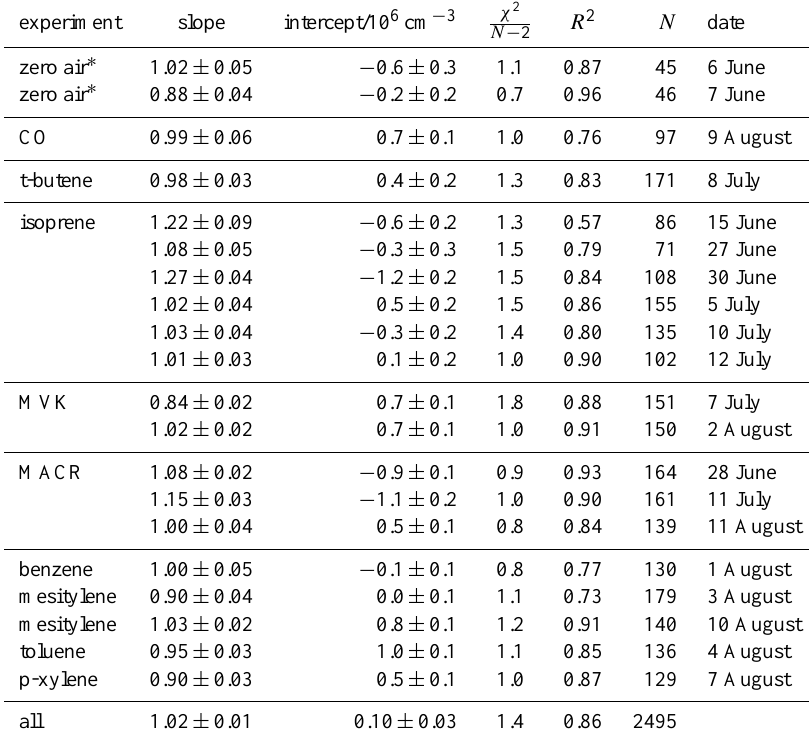
2 is the sum of squared N − 2